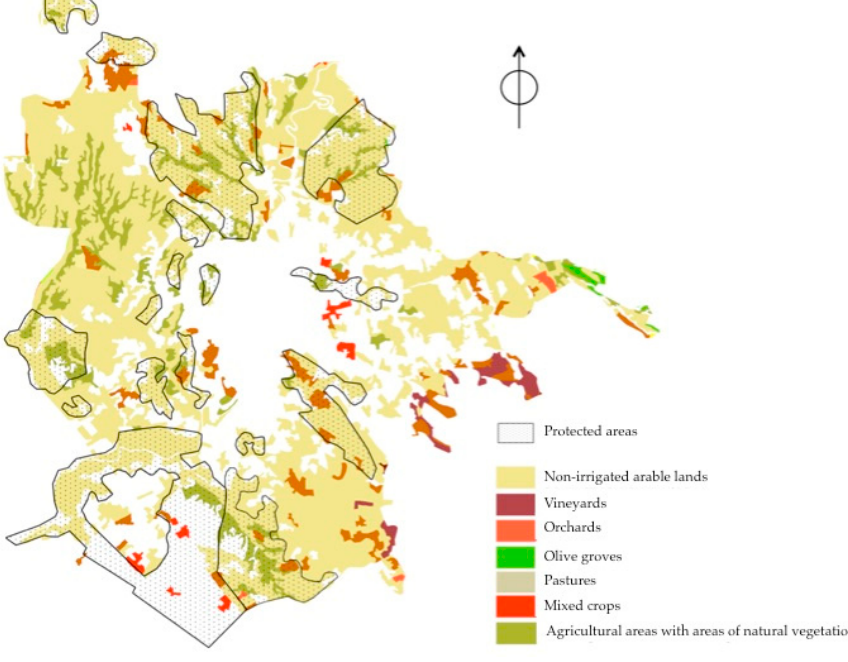
Figure 2. Land uses and protected areas in the Municipality of Rome, scale 1: 100,000 (Source: [42] using data from Corine Land Cover, 2006).